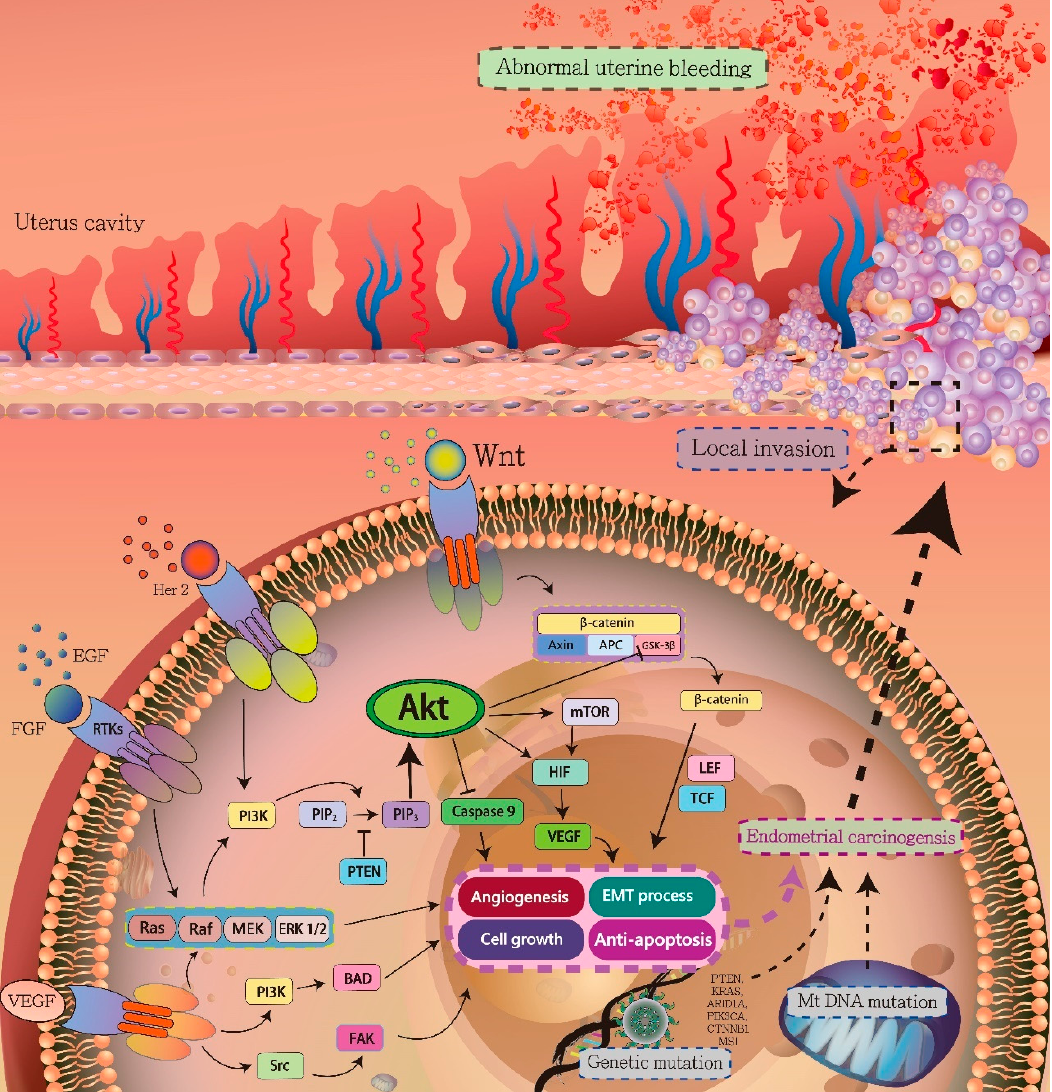
Figure 1. Schematic drawing presents the detail signaling pathways of endometrial carcinogenesis. The genes mutations and imbalance of estrogen and progesterone may triggered the several pathways, including Ras/Raf/MEK/ERK signaling pathway, Wnt/ β -catenin signaling pathway, AKT/PI3K Pathway, vascular endothelial growth factor (VEGF) pathway, and mtDNA mutation, involved in carcinogenesis to induce cell proliferation, angiogenesis, epithelial-mesenchymal transition, and anti-apoptosis effect, promoting the cancer cell to local invasion and distant metastasis.